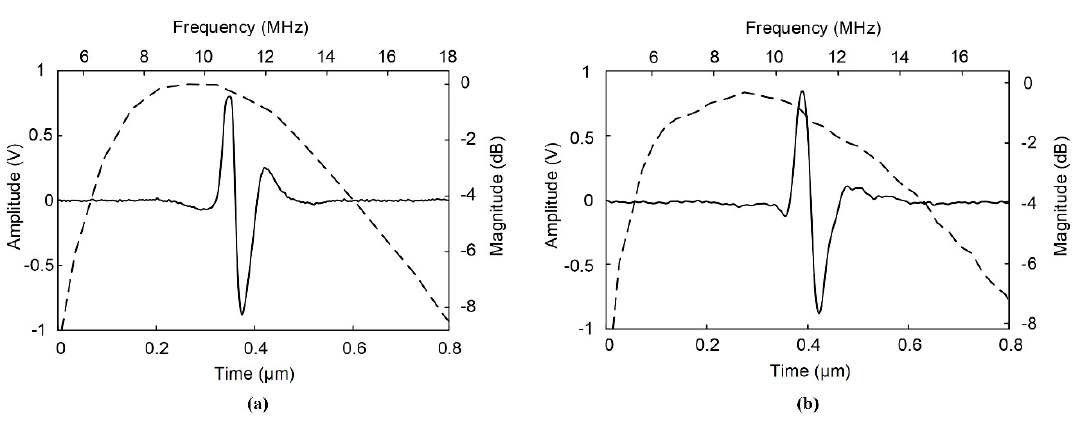
Figure 11. The measured pulse-echo and frequency spectra of transducers after forming a hole of ( a ) the single focal point transducer and ( b ) the seven-focal point transducer.